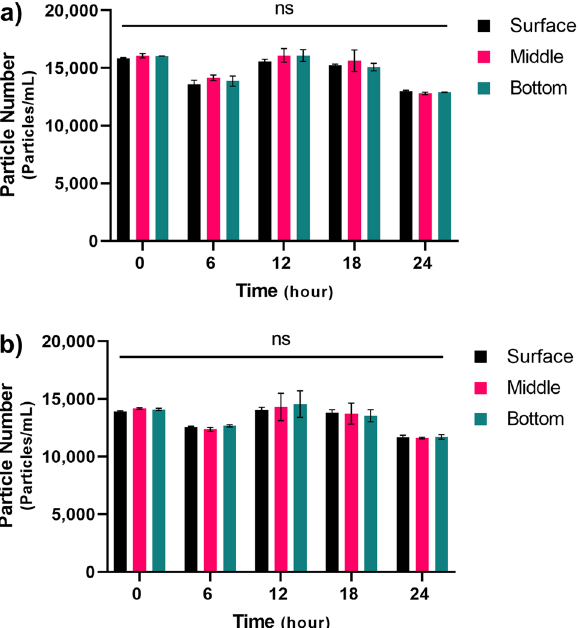
Figure 4. Microplastic vertical distribution. ( a ) Seawater, ( b ) Freshwater. Vertical distributions of polystyrene microplastics (0.25 mg/L) at the surface, middle, and bottom of the solution were measured using a microplate reader. The black bar indicates the MP particle number at the surface. The magenta bar indicates the MP particle number in the middle, whereas the blue bar shows the concentration at the bottom of the solution in seawater and freshwater. Differences between areas were analyzed for significance using one-way ANOVA ( ns non- significant P >